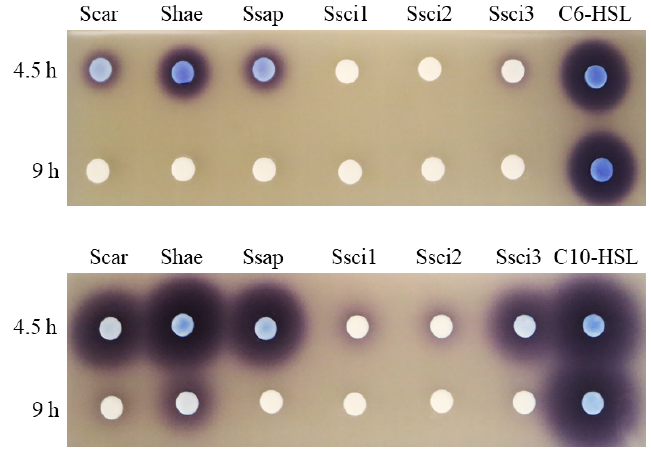
Figure 1. N -Acylhomoserine lactone (AHL)-degrading activities of CNS strains. Full-grown cultures of CNS strains, Staphylococcus carnosus NBRC 109622 (Scar), Staphylococcus haemolyticus NBRC 109768 (Shae), Staphylococcus saprophyticus NBRC 102446 (Ssap), Staphylococcus sciuri American Type Culture Collection (ATCC) 29060 (Ssci1), S. sciuri 29061 (Ssci2), and S. sciuri StLB252 (Ssci3) were mixed